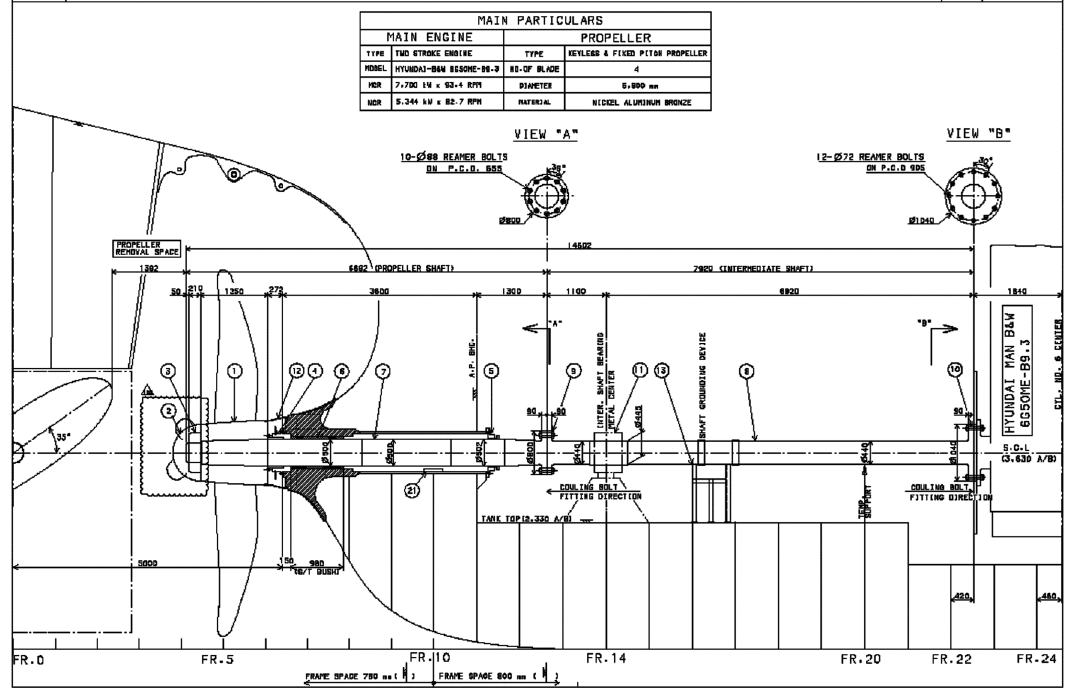
Figure 2. Shafting system of the case study ship (courtesy of the shipyard).